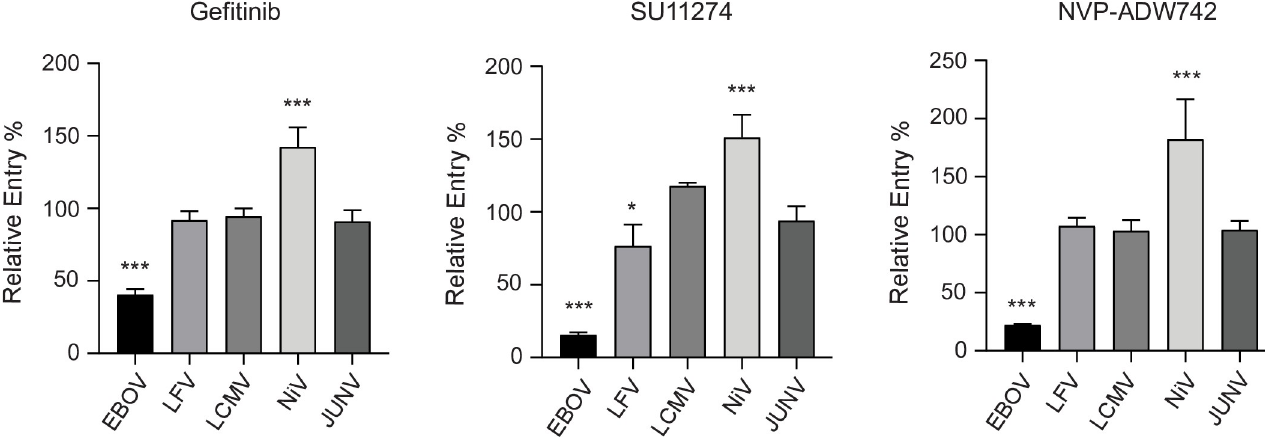
Fig 3. RTK inhibitors do not inhibit entry mediated by a panel of other viral GPs. Vero cells were transduced with MLV pseudotypes encoding LacZ and harboring EBOV, LFV, LCMV, Nipah, or Junin glycoproteins in the presence of Gefitinib (1 μ M), SU11274 (1 μ M), NVP-ADW742 (1 μ M) or vehicle (DMSO, 0.1%). Results are expressed as mean ± s.d. of triplicates and are representative of 3 experiments. � p < 0.05, �� p < 0.01, ��� p <